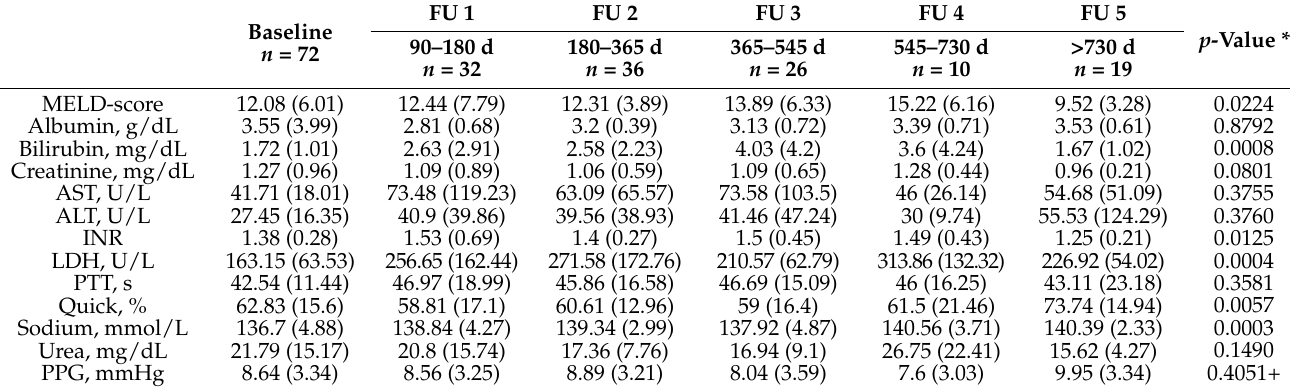
Table 2. Baseline and follow-up laboratory data and pressure measurements regarding TIPS insertion (mean (SD)). Baseline n = 72